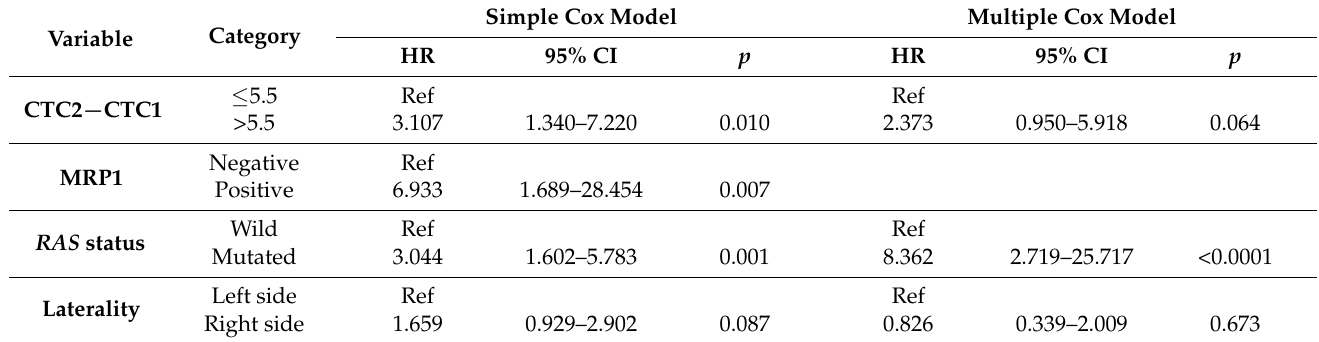
Table 3. Estimate of the parameters of the simple and multiple Cox regression model for progression-free survival from metastatic colon